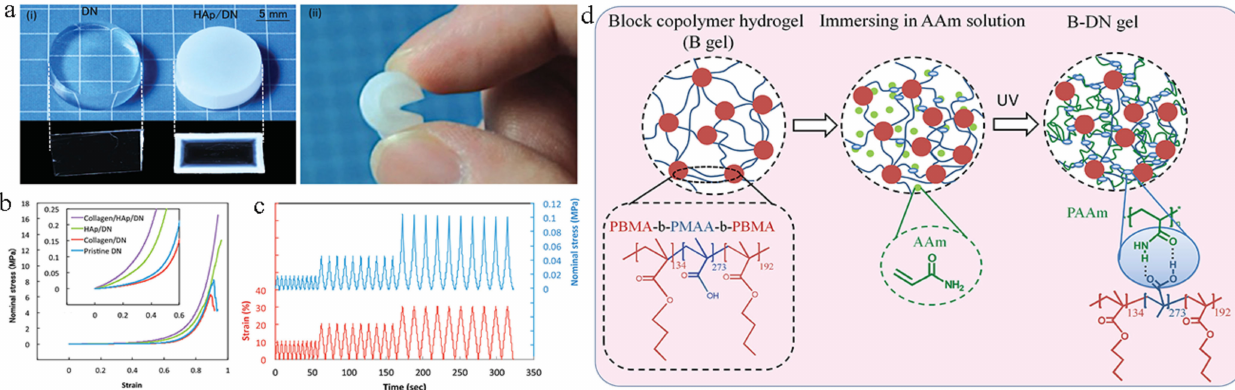
Figure 2. ( a ) Image of HAp/DN gel (hydroxyapatite nanospheres/dual network gel) ( i ) cross-sectional image; ( ii ) HAp/DN gel shows high elasticity. ( b ) Compressive stress-strain curves of HAp/DN, pristine DN, collagen/DN, and colla- gen/HAp/DN gels, and the inserted figure is the enlarged view of the low strain region. ( c ) Repeated compressive tests of HAp/DN for ten times at each strain; 10%, 20%, and 30% [22]. ( d ) Structure of block copolymer gel (B gel), the synthesis procedure of the double-network gel (B-DN gel), and the structure of B-DN gel with hydrogen bonds